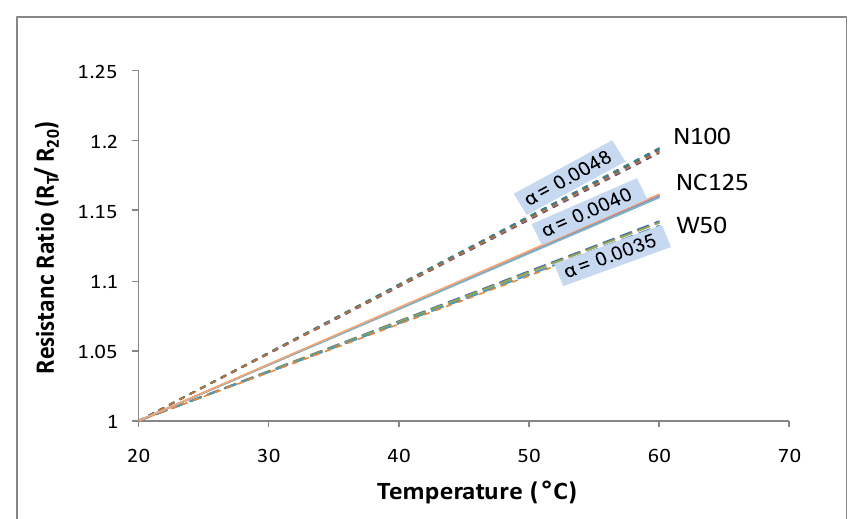
Figure 4. Fitted resistance ratios along with their corresponding alpha values (Temperature coefficient of